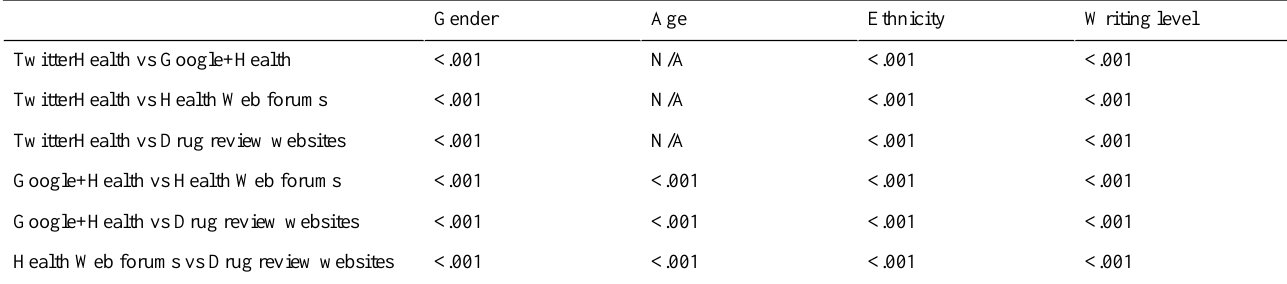
Table 8. P values for Pearson’s chi-square test of